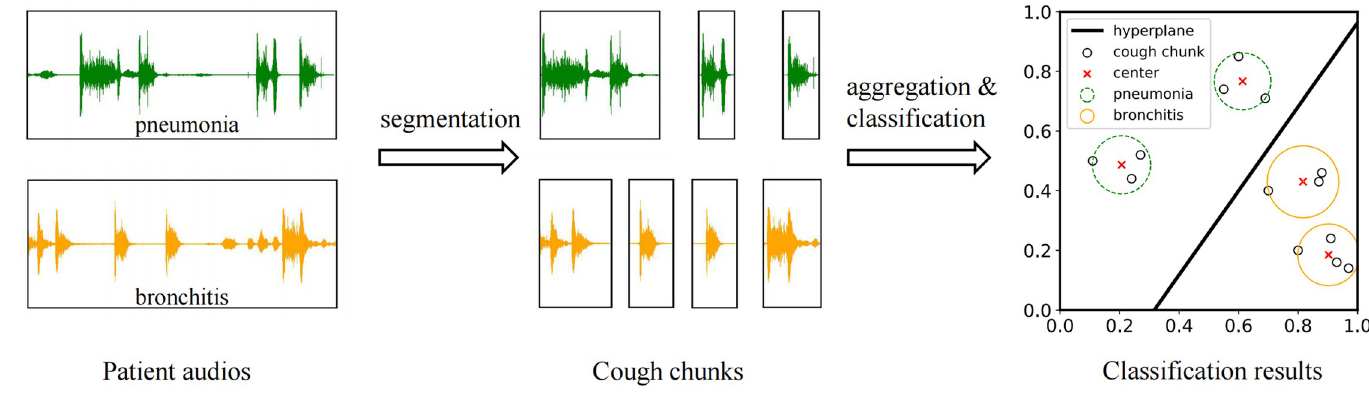
Fig 1. Overview of the Classification Framework based on Cough Sounds (CFCS).